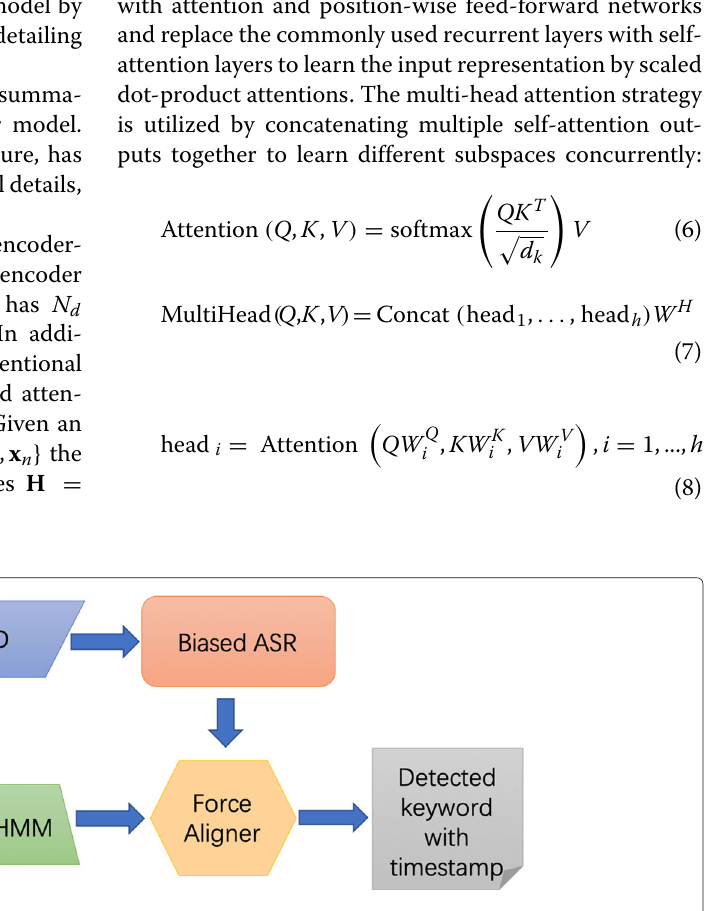
model for alignment. Our proposed KWS architecture is depicted in Fig.